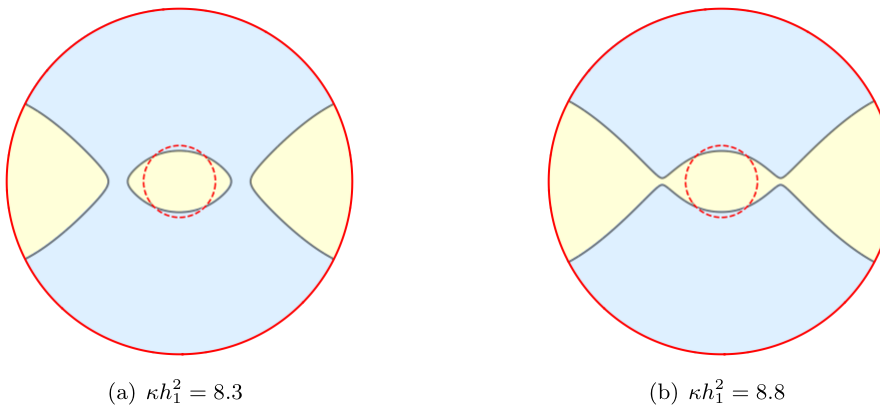
Figure 3 . Perturbative solution with m = (cid:0) (cid:30) h = 1 on the unit disk. Yellow regions indicate positive curvature while blue ones, negative. The interpolating region with (cid:30) = 0 is the solid curve between them. The red dashed circle shows the interpolating region of the unperturbed geometry. As the strength of the perturbation increases, the positive curvature regions grow until negative curvature regions become